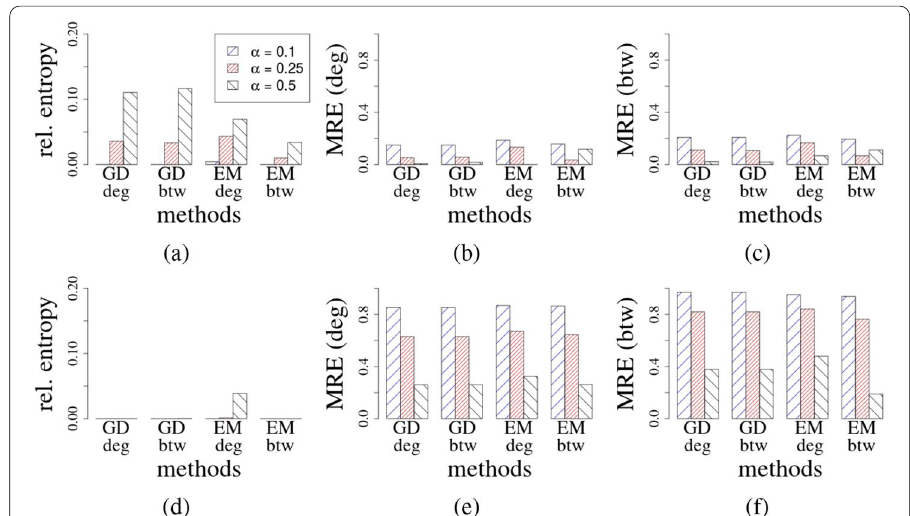
Fig. 10 Normal distributions: relative entropy (column one), mean relative error of expected degree (column two) and mean relative error of expected ego betweenness (column three) of sparsified Erdős–Rényi graphs with 500 nodes and density ρ = 0.5 . Edge probabilities are assigned according to Normal distributions (row